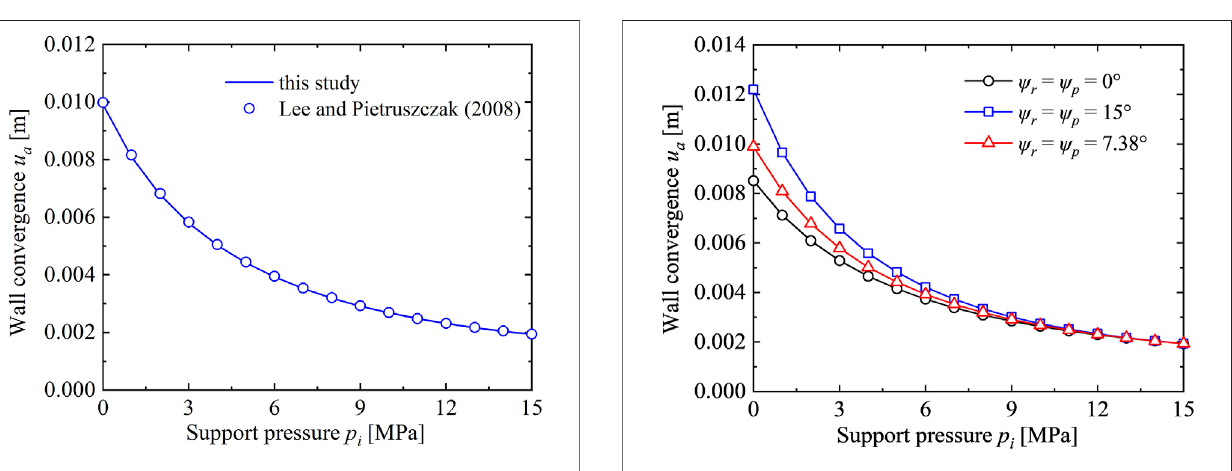
FIGURE 6 | Comparison with theoretical solution of Lee and Pietruszczak (2008).